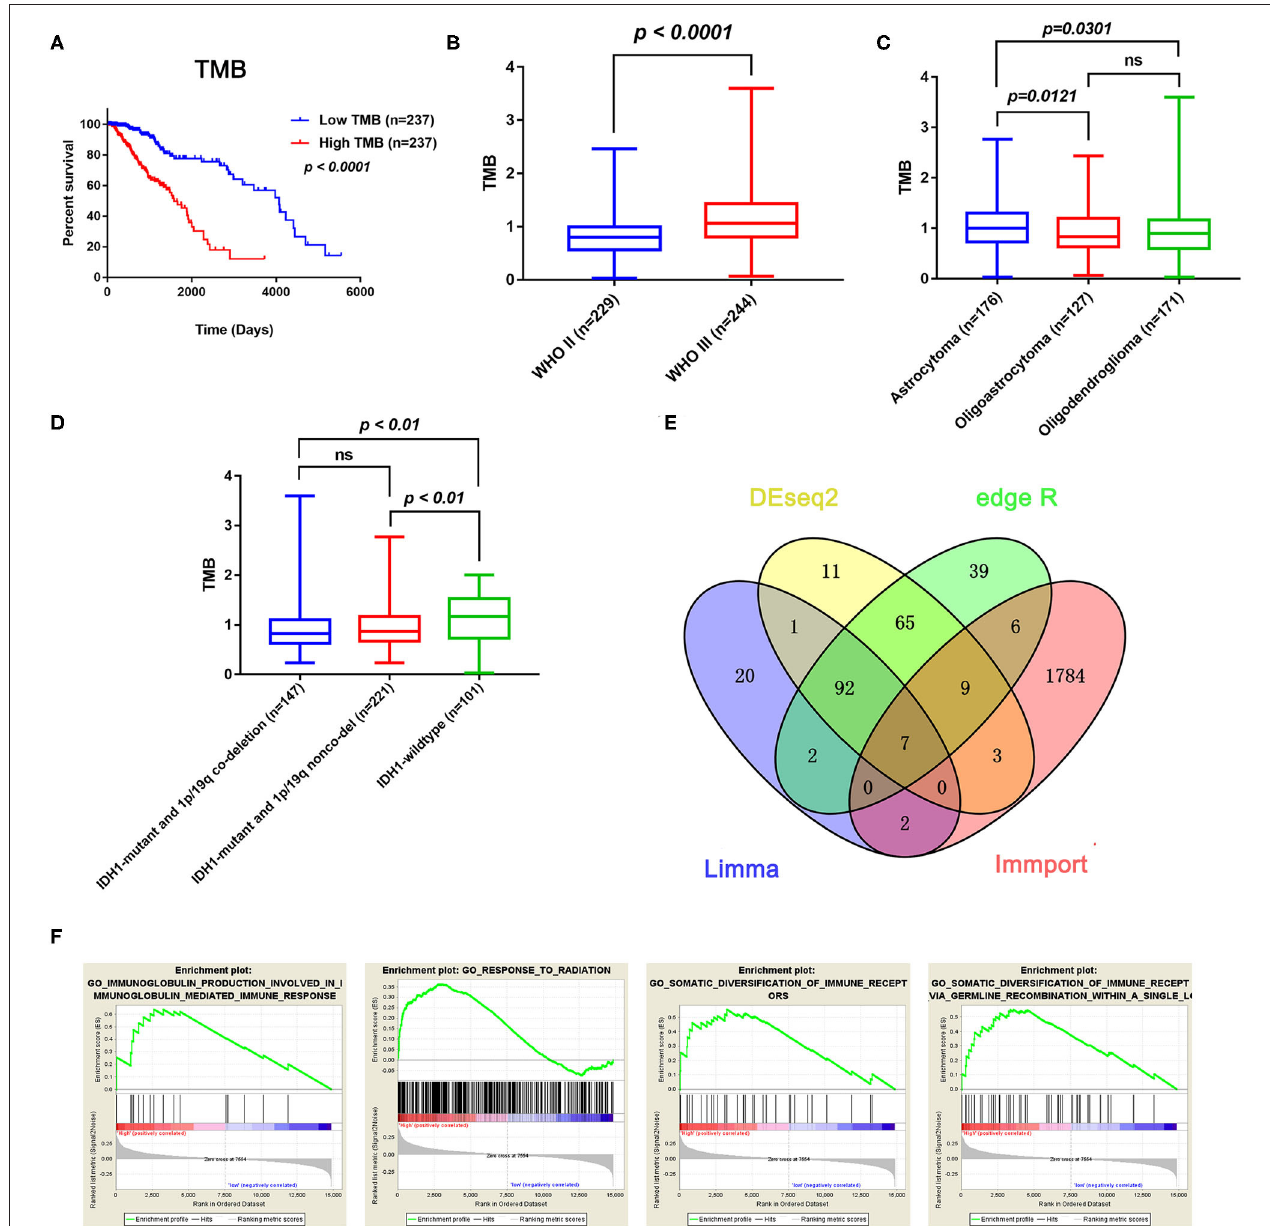
FIGURE 2 | Prognostic value of TMB and a comparison of the gene expression profiles in high and low TMB groups. (A) Kaplan–Meier analysis showing that higher TMB levels correlated with a poor prognosis ( p < 0.0001). (B) A higher TMB level was found in advanced grade tumors ( p < 0.0001). (C) Comparison of the TMB levels with the different pathological types. Astrocytoma has higher TMB levels than oligoastrocytoma and oligodendroglioma ( p = 0.0121 and p = 0.0301). (D) Lower TMB levels were associated with IDH1 mutant LGGs ( p < 0.01). (E) Identification of TMB-related immune genes. (F) GSEA showed immune-related biological processes between the high- and low-risk